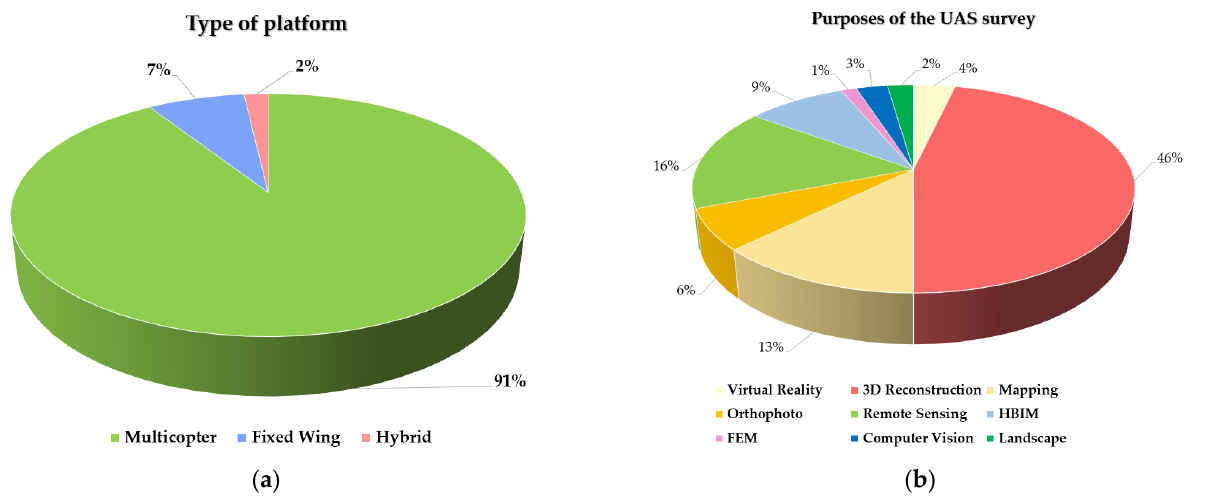
Figure 13. Representation by means of a pie chart of literature review on platform type ( a ) and purposes of UAV photogrammetry in CH ( b ).